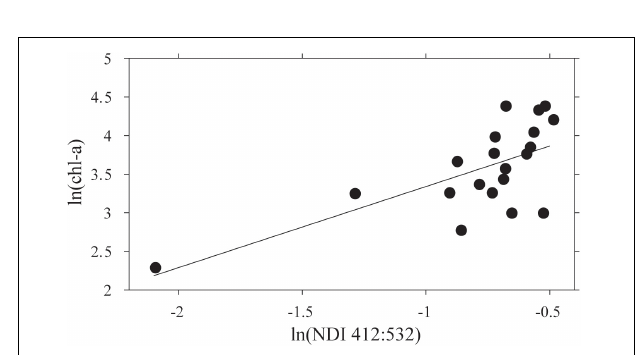
FIGURE 5 | The relationship between ln(NDI 412:532) and ln(chl-a) for means of the three sample cores collected at each of 20 stations. The regression line fitted is ln(chl-a) = 1.05 ln(NDI)+4.39 ( R 2 = 0.44; N = 20; F = 14.15; p =